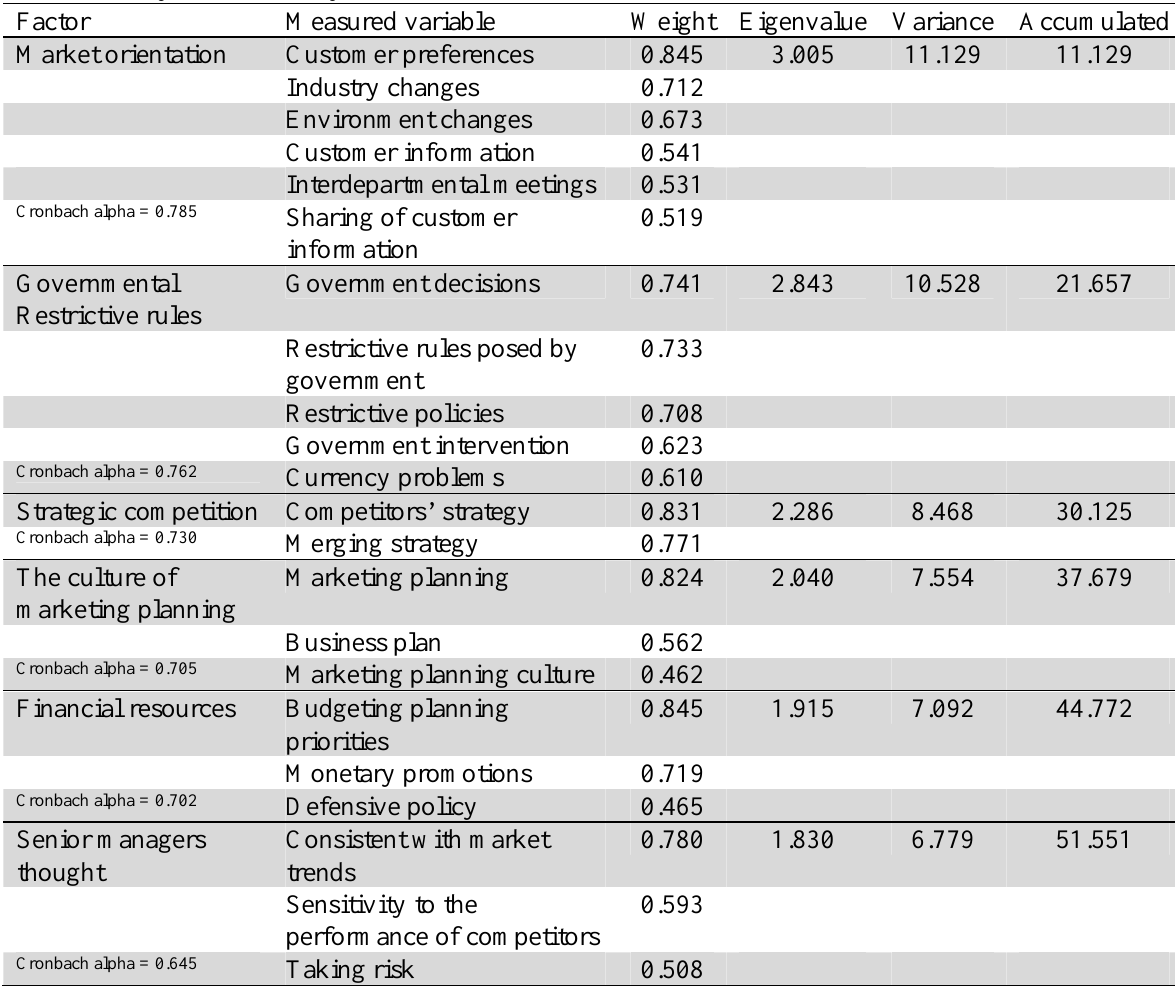
The summary of factor